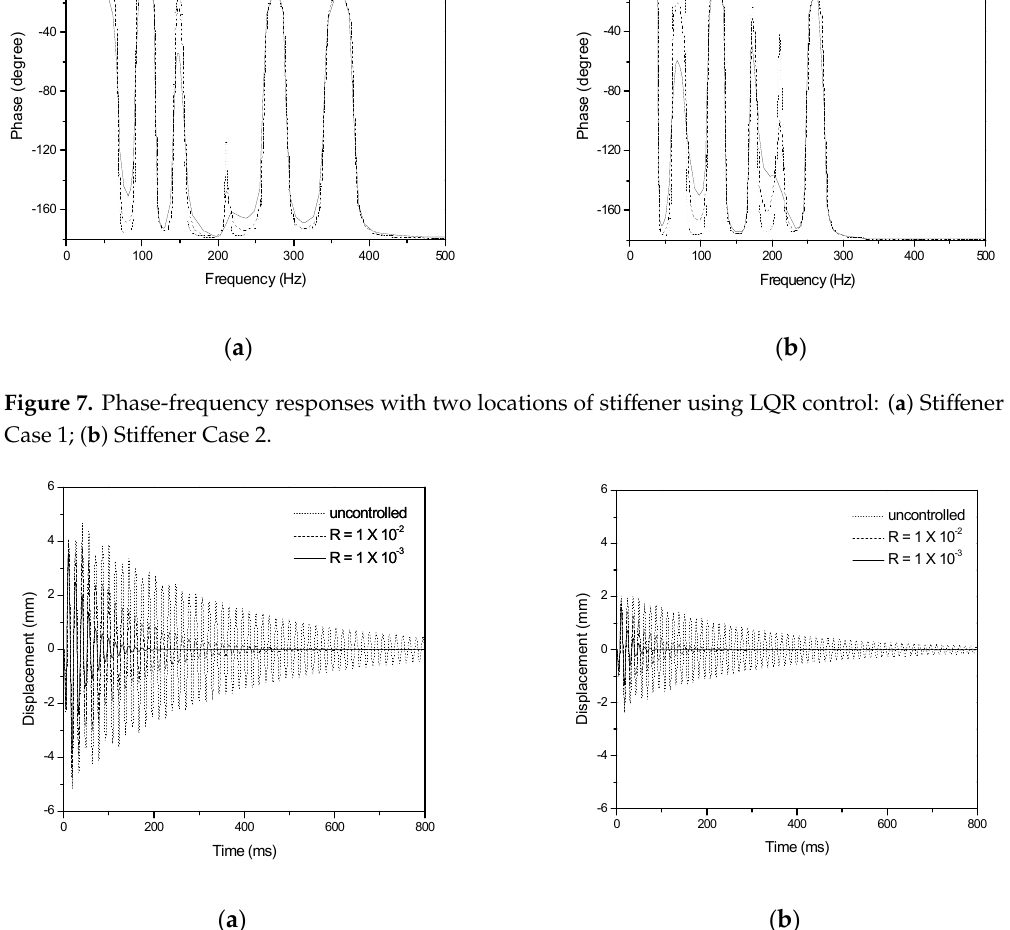
Figure 7. Phase ‐ frequency responses with two locations of stiffener using LQR control: ( a ) Stiffener Case 1; ( b ) Stiffener Case 2.